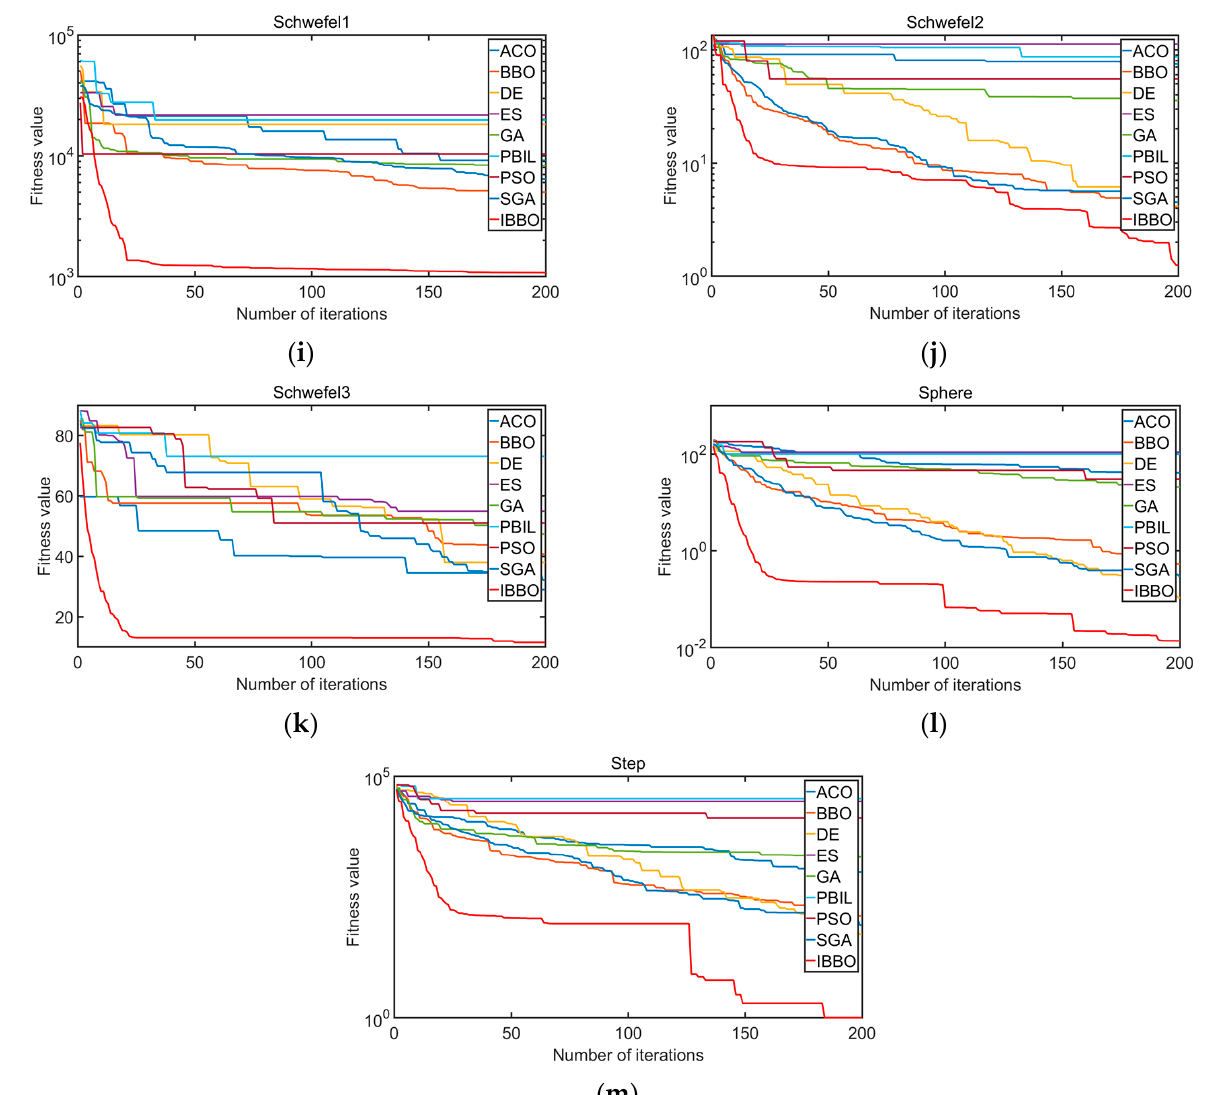
Figure 7. ( a ) Convergence of nine algorithms under Ackley function; ( b ) convergence of nine algorithms under Flethcher function; ( c ) convergence of nine algorithms under Griewank function; ( d ) convergence of nine algorithms under Penalty1 function; ( e ) convergence of nine algorithms under Penalty2 function; ( f ) convergence of nine algorithms under Quartic function; ( g ) convergence of nine algorithms under Rastrigin function; ( h ) convergence of nine algorithms under Rosenbrock function; ( i ) convergence of nine algorithms under Schwefel1 function; ( j ) convergence of nine algorithms under Schwefel2 function; ( k ) convergence of nine algorithms under Schwefel3 function; ( l ) convergence of nine algorithms under Sphere function; ( m ) convergence of nine algorithms under Step